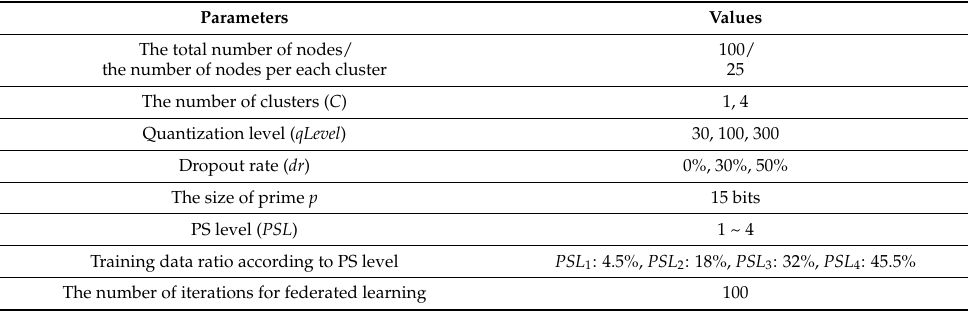
Table 3. Experimental parameters and